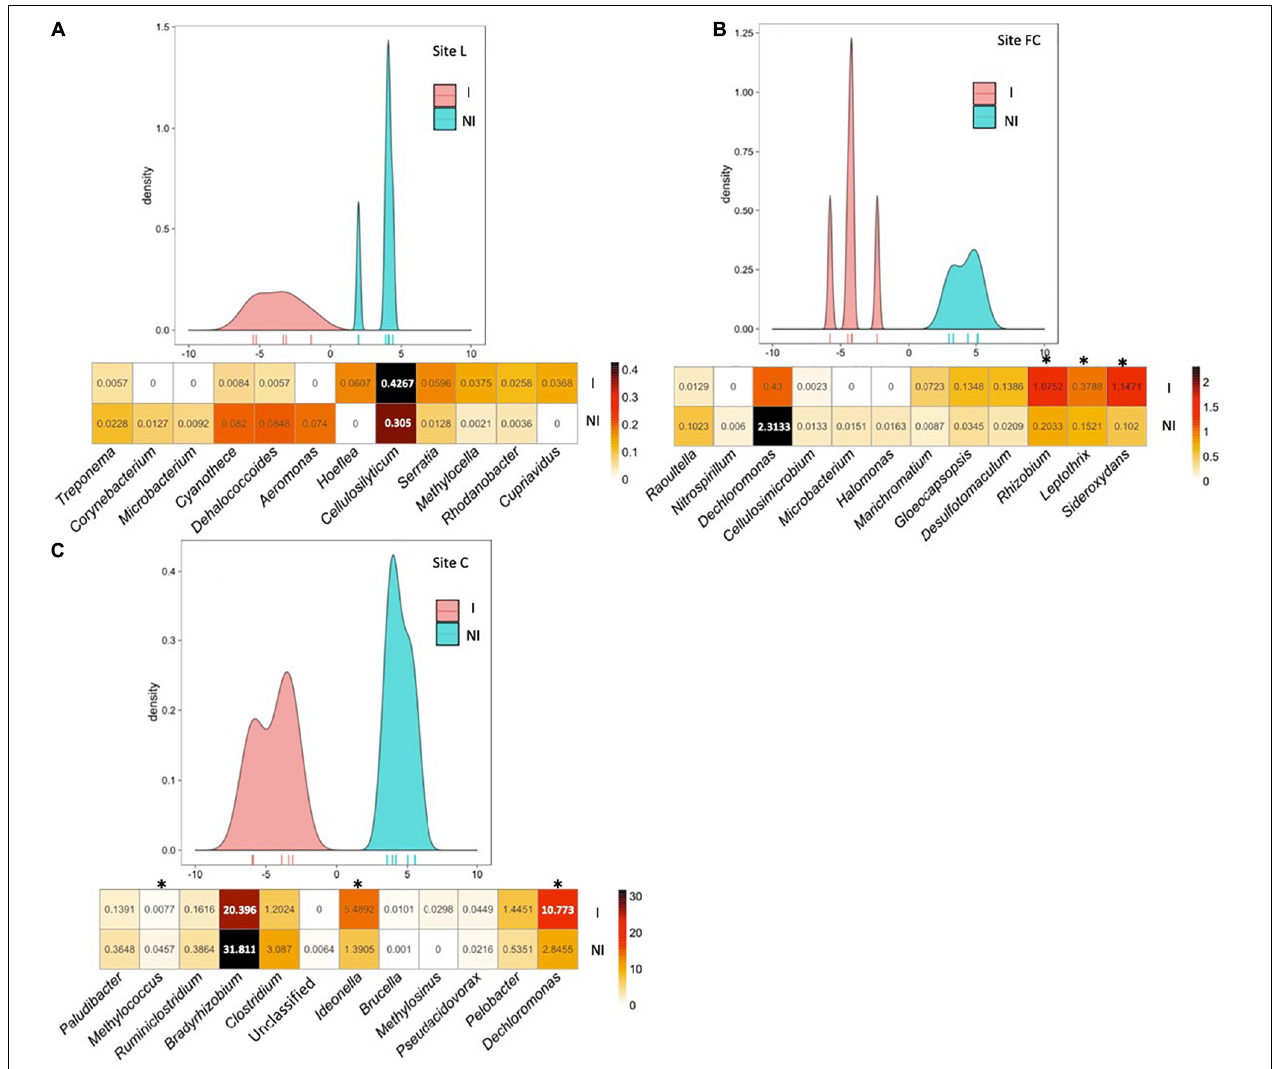
FIGURE 2 | Between-class analysis of the effect of seed inoculation with A. lipoferum CRT1 on the composition of the nifH functional group in the maize rhizosphere at the six-leaf stage at three field sites L (A) , FC (B) , and C (C) , in 2015. NI and I correspond, respectively, to non-inoculated and inoculated conditions. For each site, the BCA graph is completed (below) by the distribution of the bacterial OTUs according to their contribution to treatment differentiation; BCA is supported statistically by a Monte Carlo test at sites L ( p = 0.008), FC ( p = 0.007), and C ( p = 0.006), and the heatmap below indicates the average relative proportions for the 12 bacterial genera most impacted by inoculation in maize rhizosphere. Six bacterial genera most commonly associated with inoculation are indicated at the left, as well as six bacterial genera most often associated with the non-inoculated control (right). Statistical differences between inoculated and non-inoculated treatments are indicated by stars ( ∗ ) (Wilcoxon test, p < 0.05). Heatmap unit is a percentage of the average relative proportion of